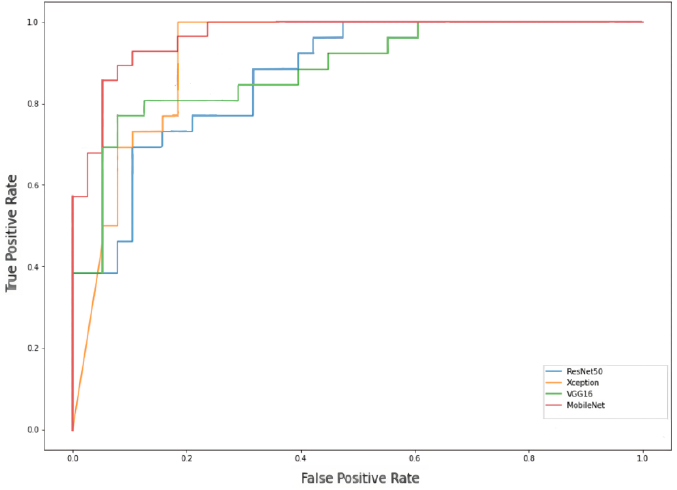
Figure 6. ROC curve for all